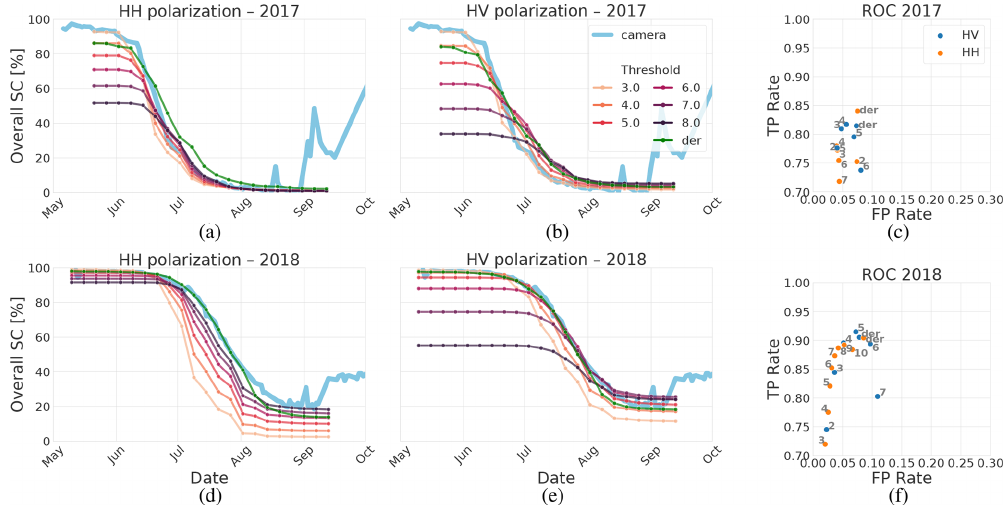
Figure 8. (a, b, d, e) Seasonal development of overall snow cover (SC) in Zackenberg of the Sentinel-1 products (SC_DOY S-1 ) for the threshold–polarization configurations as well as the derivative (der) compared to orthorectified time-lapse imagery (SC_DOY camera ). Autumn SC is not detected by the proposed approach as only the seasonal decrease in SC is observable. (c, f) Receiver operator characteristic (ROC) derived from the overall true positive (TP) rates and false positive (FP) rates of the SC maps of (c) 2017 and (f) 2018 based on same-day S-1 acquisitions and orthorectified time-lapse imagery. The used threshold is depicted as a label next to each point.